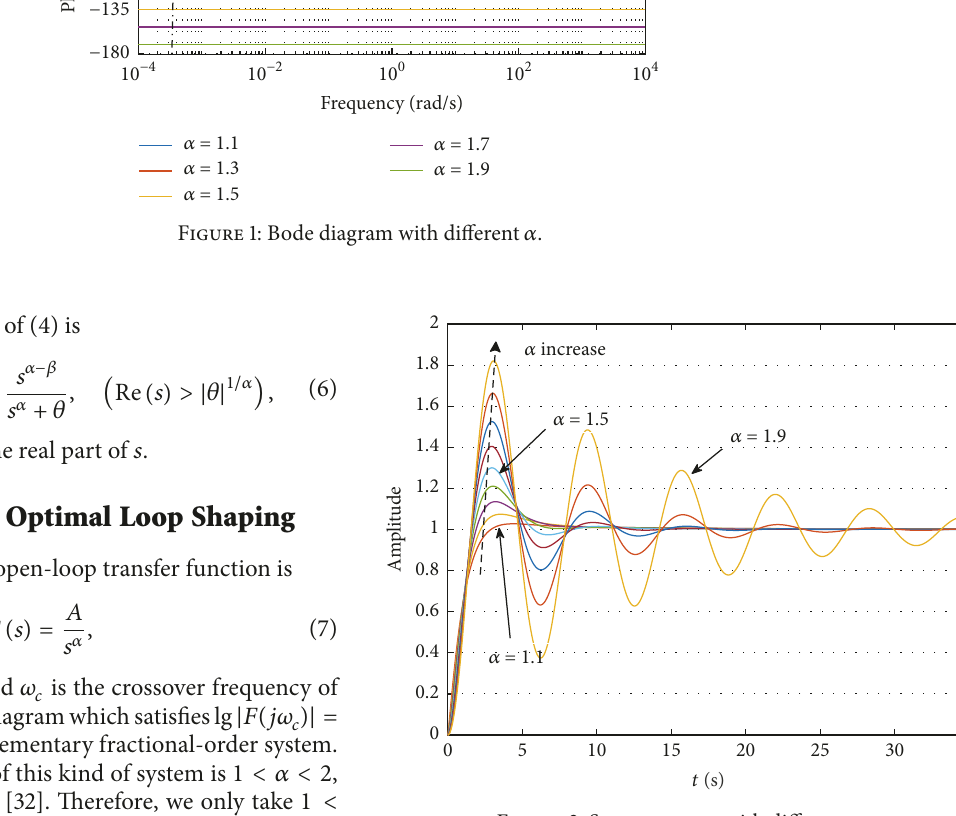
Figure 2: Step responses with different 𝛼